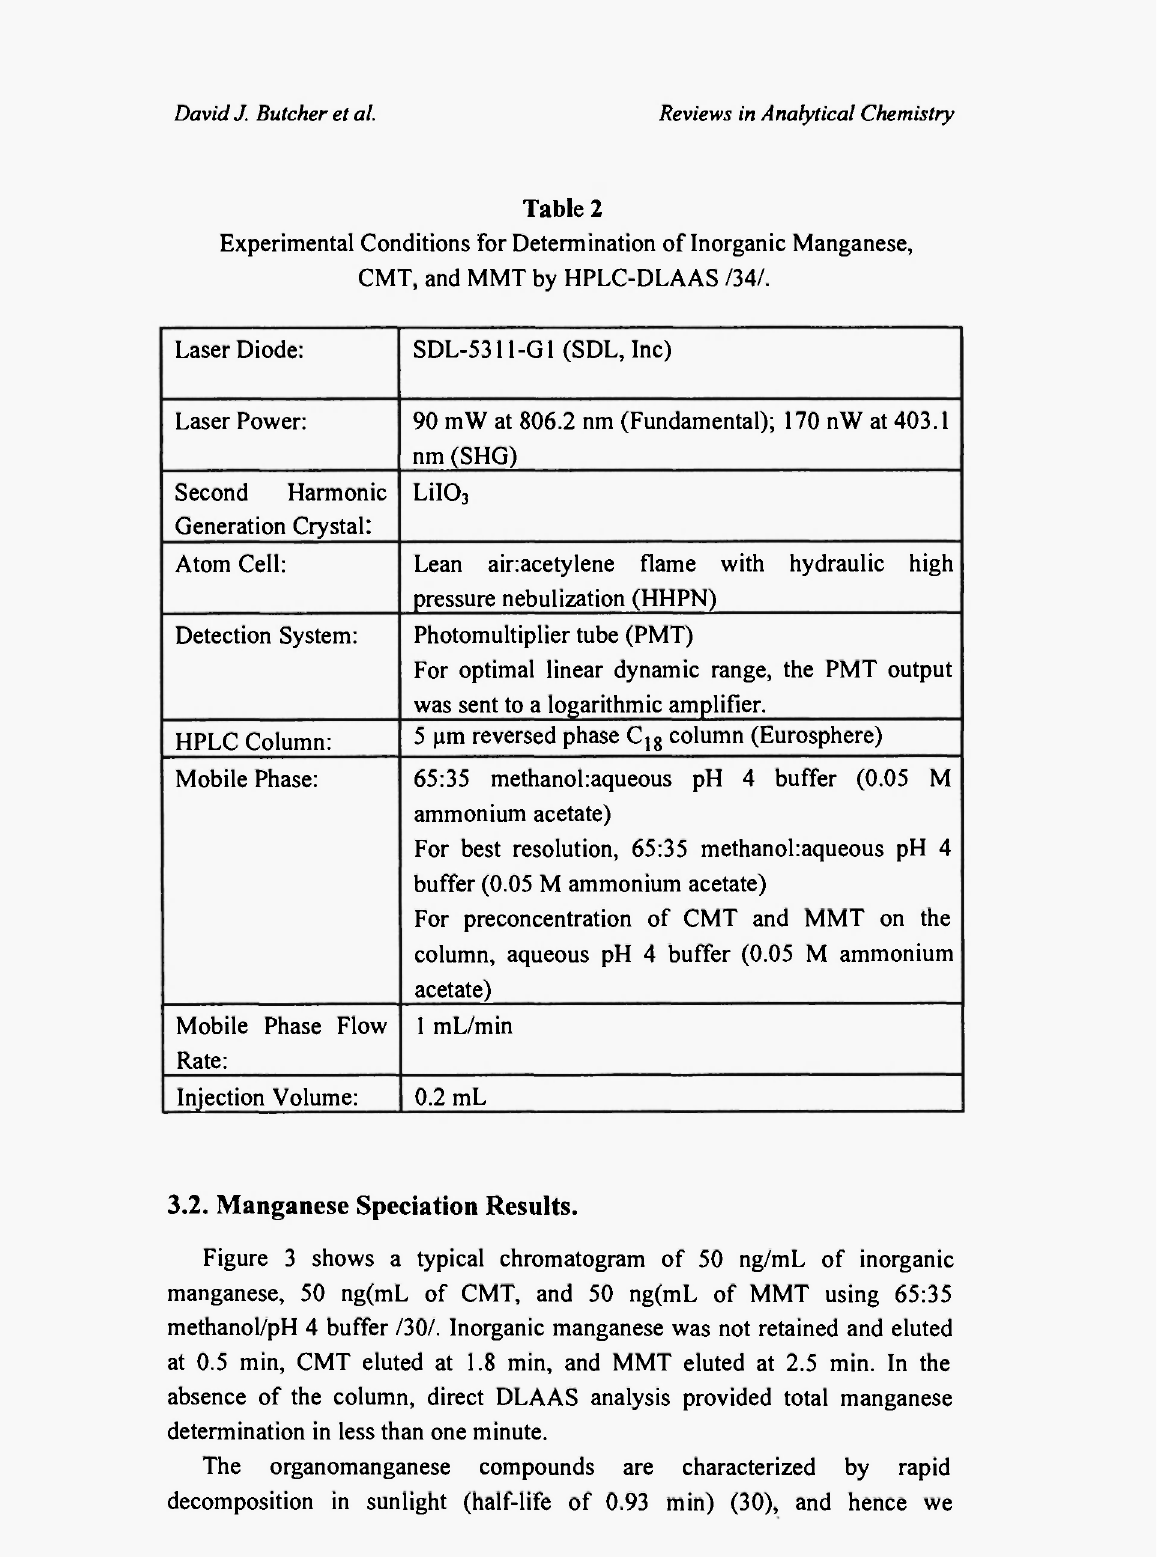
Experimental Conditions for Determination of Inorganic Manganese, CMT, and MMT by HPLC-DLAAS